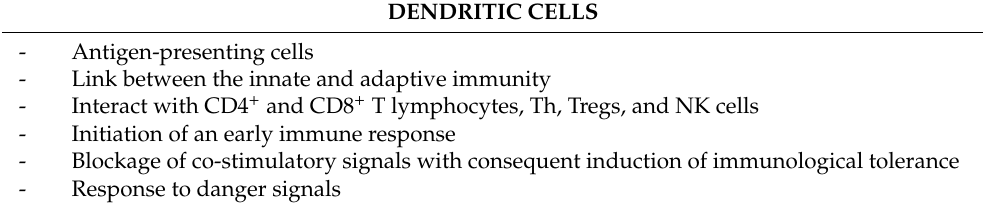
Table 2. Summary of DCs activity.